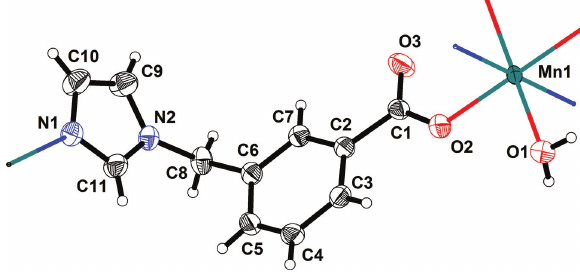
Table 1: Data collection and handling.